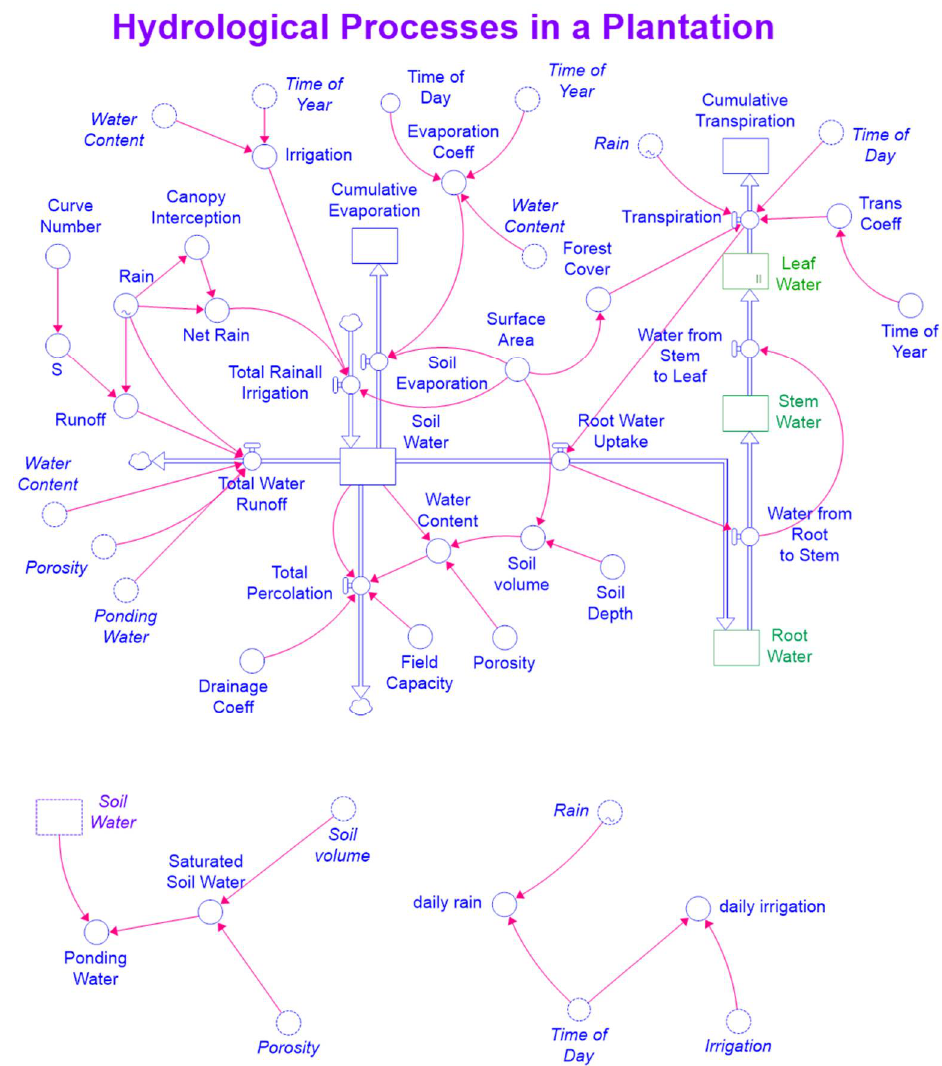
Figure 2. A map of the STELLA model for simulating hydrological processes.